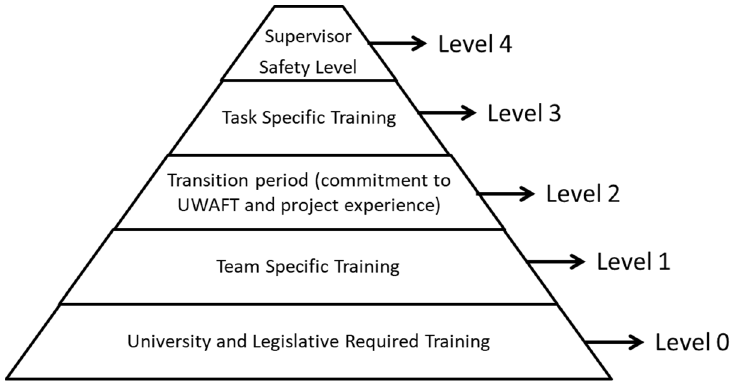
Figure 11. Development of Updated Tier System.